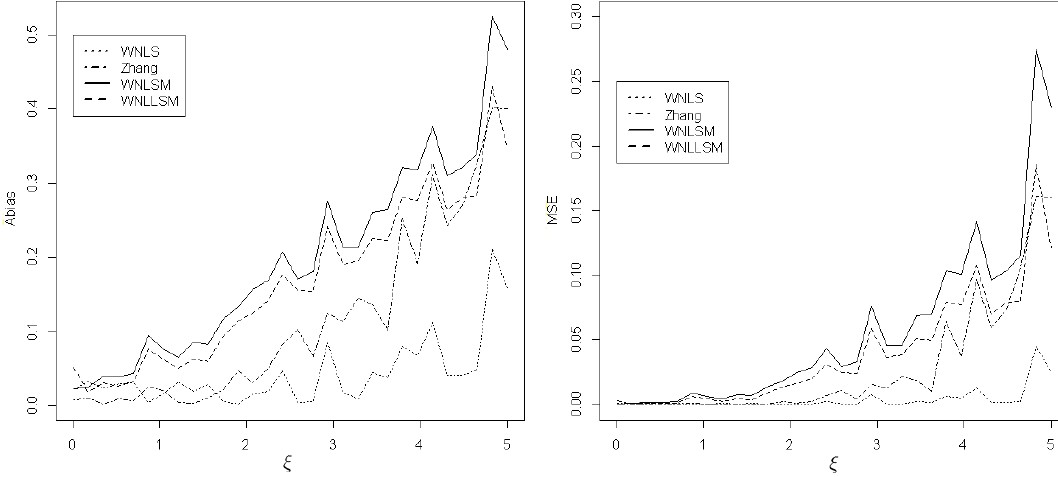
Figure 2. Abias and MSE of b for four estimators when µ = 0 and σ =